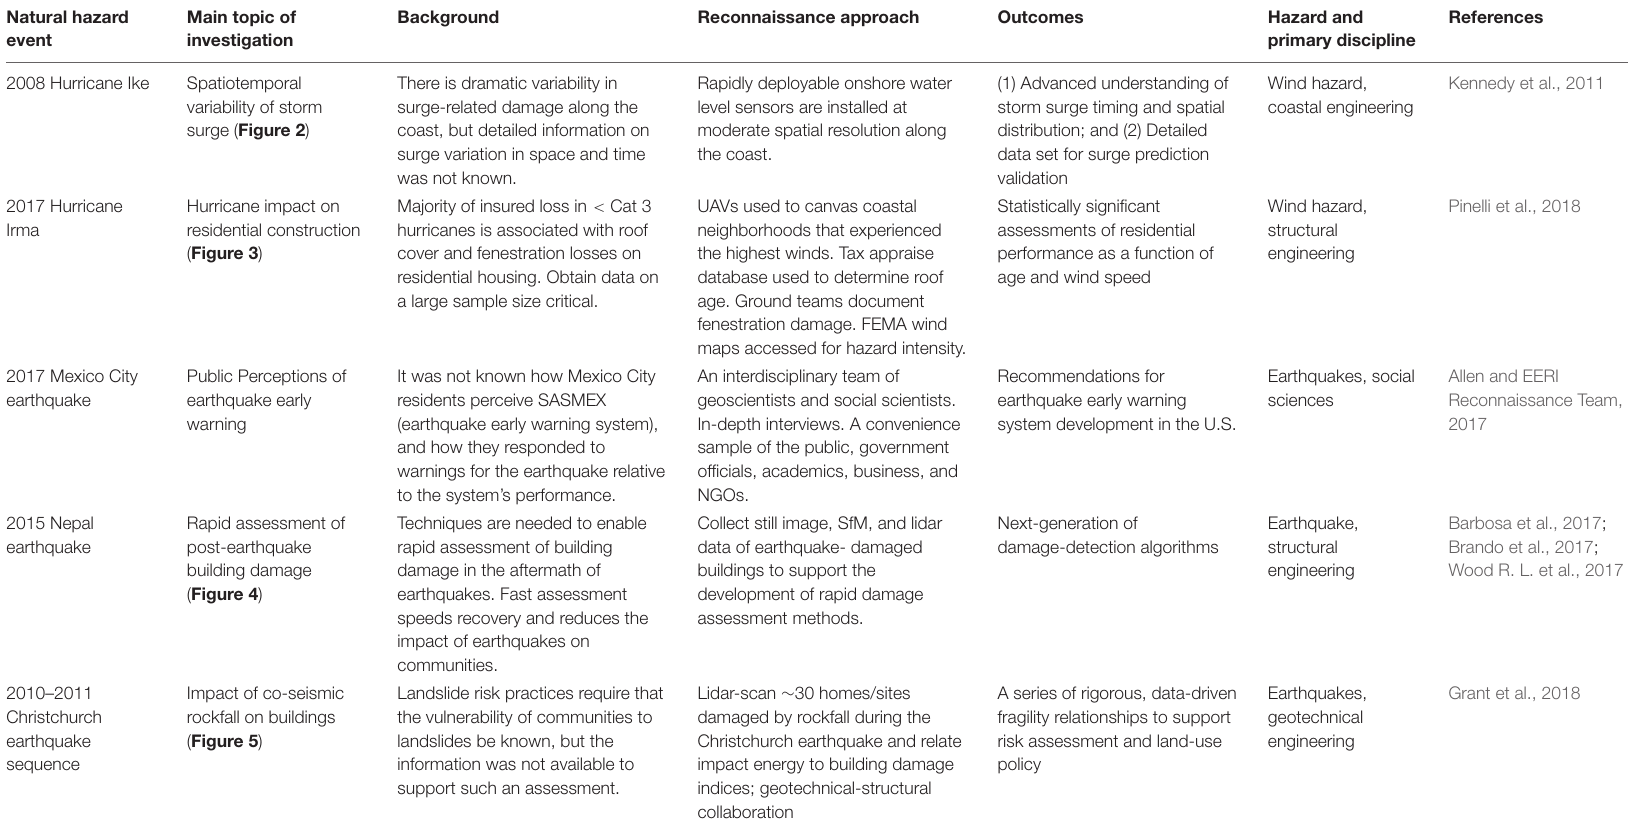
TABLE 1 | Examples of reconnaissance approach, objectives, and outcomes from several recent earthquake and wind hazard missions ( Figure 2 ).